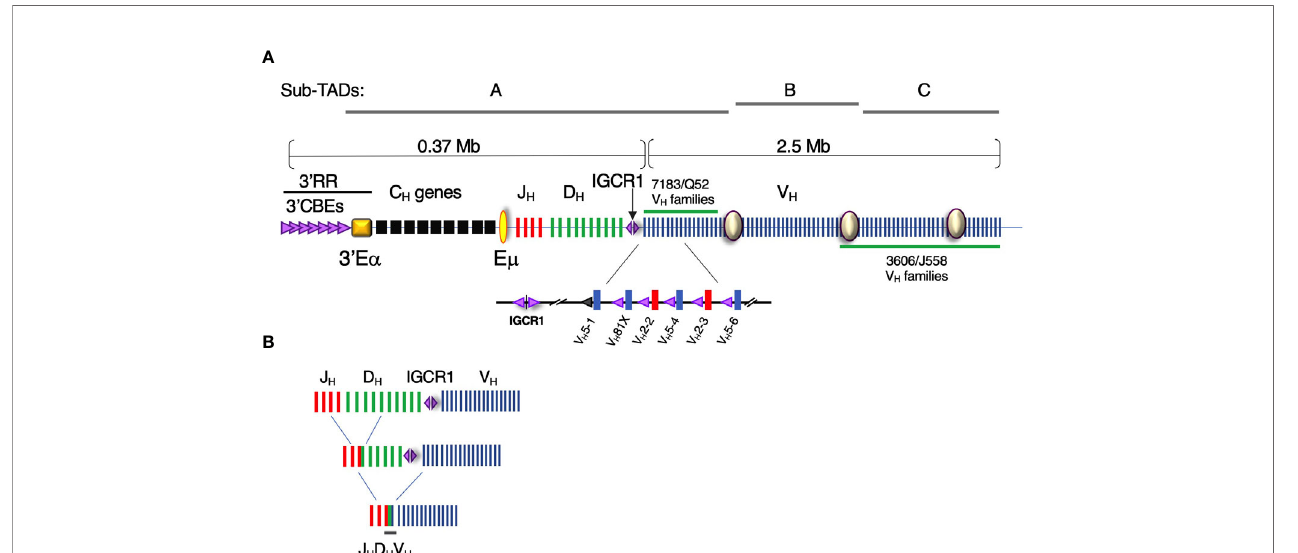
FIGURE 1 | The Igh locus contains ~100 V H gene segments over an almost 3Mb genomic interval. (A) (Upper panel) Diagram of the Igh locus indicating V H , D, J H , and C H exons and regulatory elements (not to scale). The intronic E m and 3 ′ E a super-enhancers and intergenic control region 1 (IGCR1), composed of two divergent CBEs, are critical regulatory elements. CBE orientation is indicated by (purple) triangle direction. The 3 ′ regulatory region (3 ′ RR) is a composite of nine CBEs located at the 3 ′ boundary of the Igh locus adjacent to 3 ′ E a super-enhancer. Sites I, II, and III (purple circles) anchor the sub-topologically associating domain (Sub-TADs) A, B, and C. The V H S107 family along with nine smaller V H families comprise the intermediate V H segments. The interspersed distal V H gene segments are composed of the V H J558 and V H 3609 families and are located at the 5 ’ end of the locus. (Lower panel) The V H 7183 (blue bars) and V H Q52 families (red bars) are located at the D H J H -proximal end of the locus. Each D H J H -proximal V H exon is paired with a recombination signal sequence (not shown) and a CBE (purple triangle). The CBE associated with VH5-1 exon is non-functional (gray triangle). VH81X (V H 5-2) is the second V H exon gene relative to IGCR1. (B) Schematic of the stepwise process